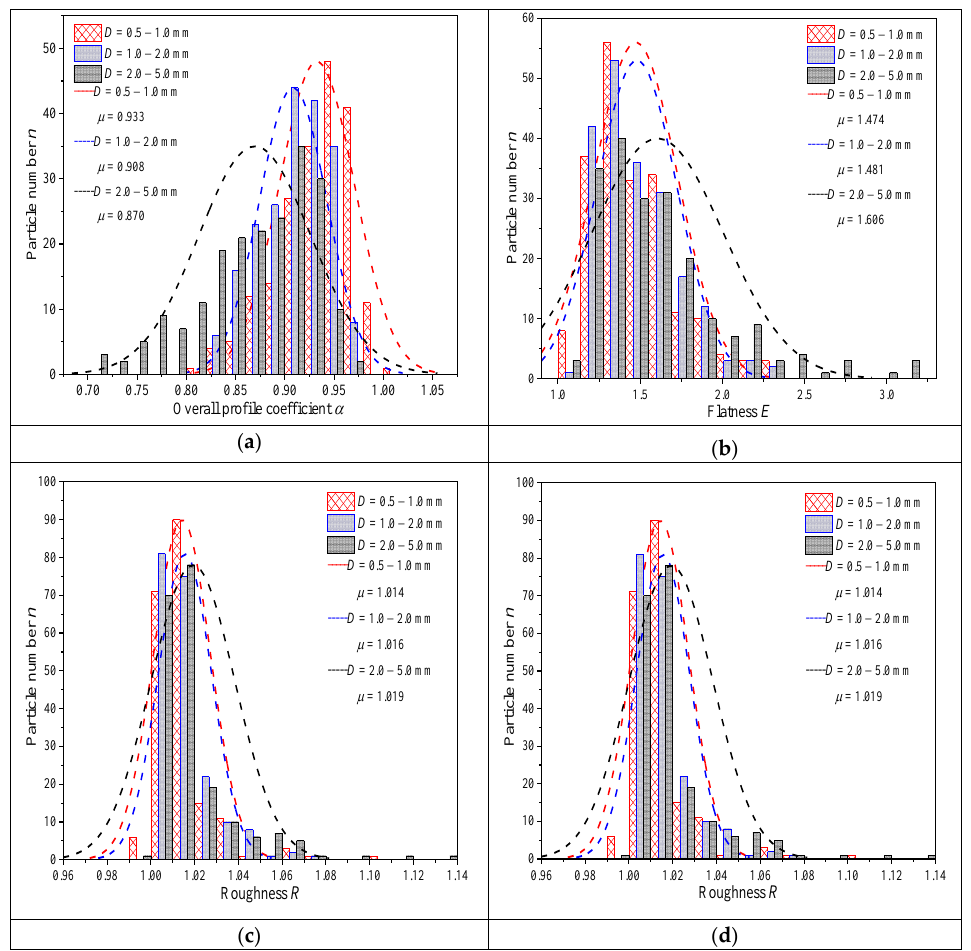
Figure 10. Shape parameter distribution of coral sand with different particle sizes: ( a ) overall profile coefficient α , ( b ) flatness E , ( c ) angularity A g , and ( d ) roughness R .